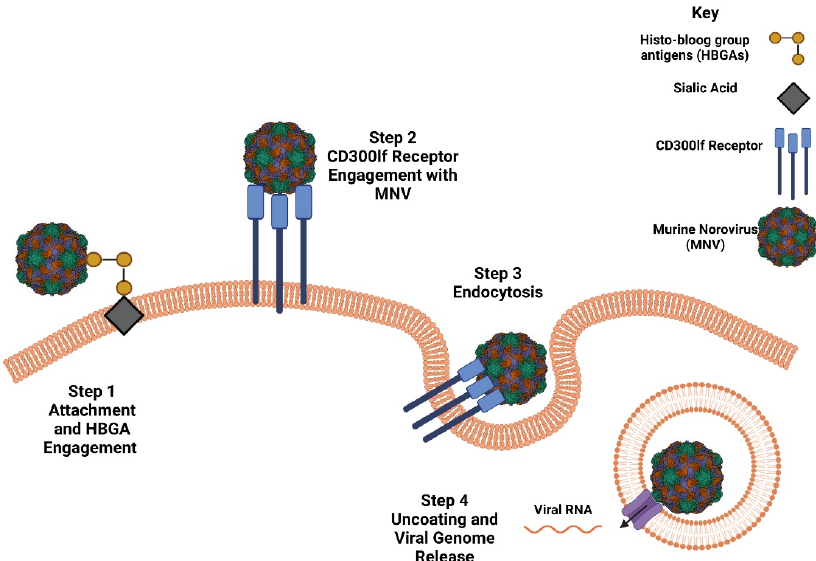
Figure 3. HBGA and Receptor Engagement with MNV-1. HBGA act as attachment factors for MNV-1, where it improves infectivity by concentrating MNV-1 on the membrane. Recently, CD300lf, a protein belonging to the CD300 family, was identified as receptor which interacts on the surface of murine macrophages with MNV-1. It belongs to a family of cell death receptors and it has proven to be essential for viral ability to infect and replicate. Interaction with CD300lf results in the initiation of viral uptake via endocytosis, which is followed by uncoating and viral genome release. Made using Biorender.com, accessed on 18 October